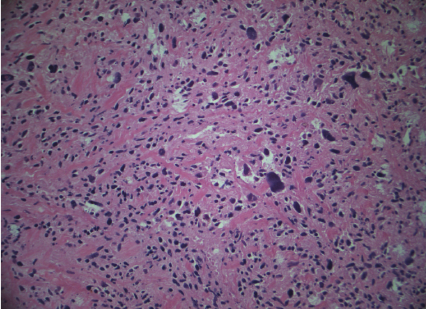
Figure 4: Malignant spindle cell proliferation with some very large tumor cells and areas of focal